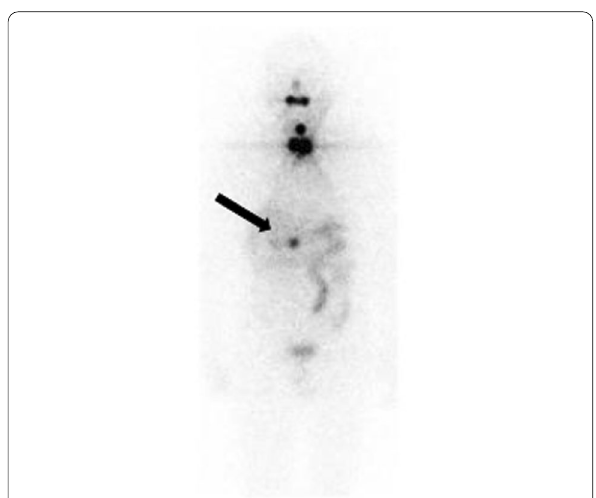
Fig. 2 Computed tomography (CT) scan showing a small round hypodense mass (10 20 mm in size) adjacent to the head of the × pancreas (black arrow)